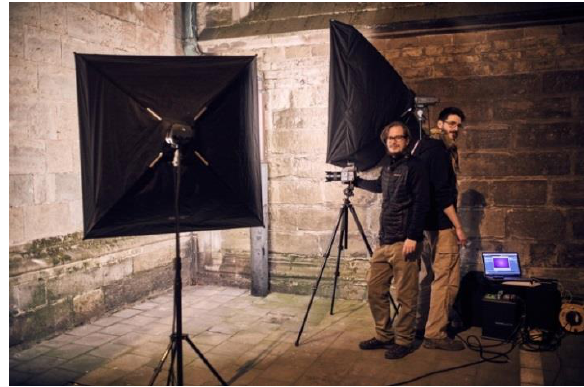
Figure 5. VIS-documentation of a trial area at Sint Baafs